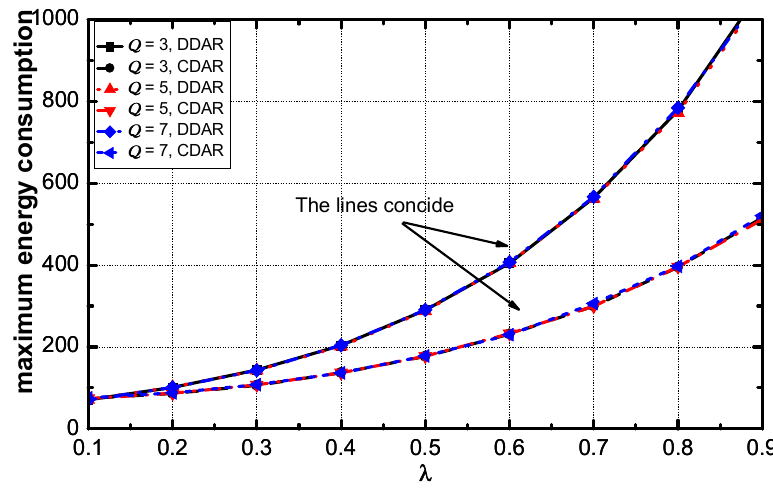
Figure 13. Average maximum energy consumption vs. λ .